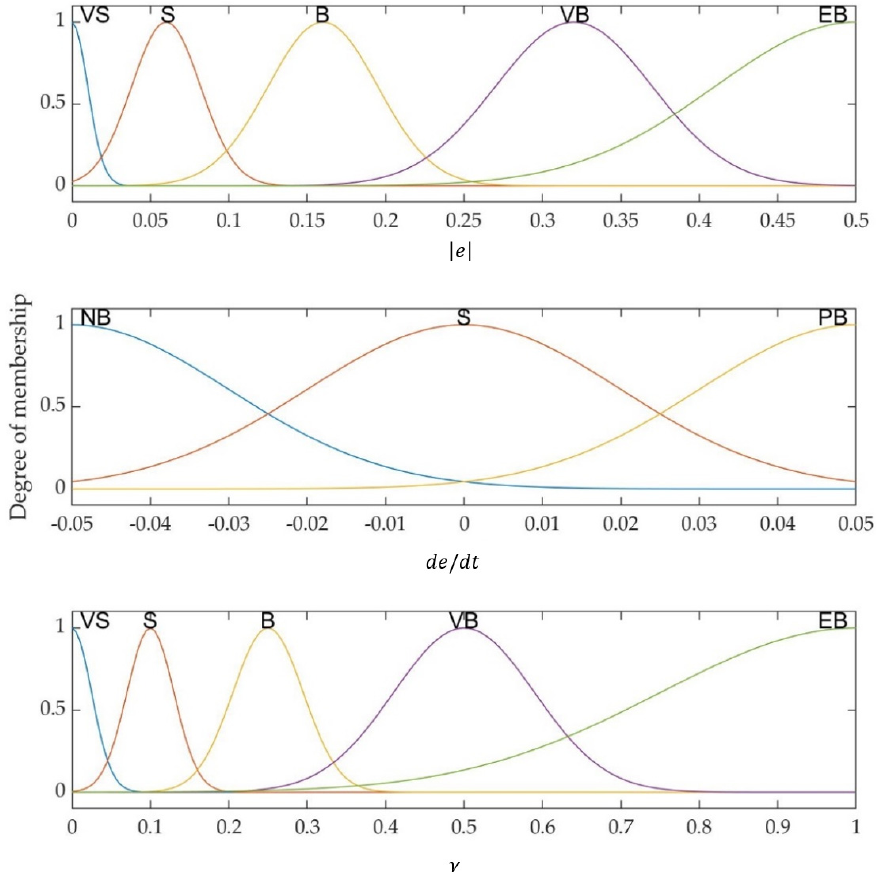
Figure 6. Fuzzy input/output membership functions.